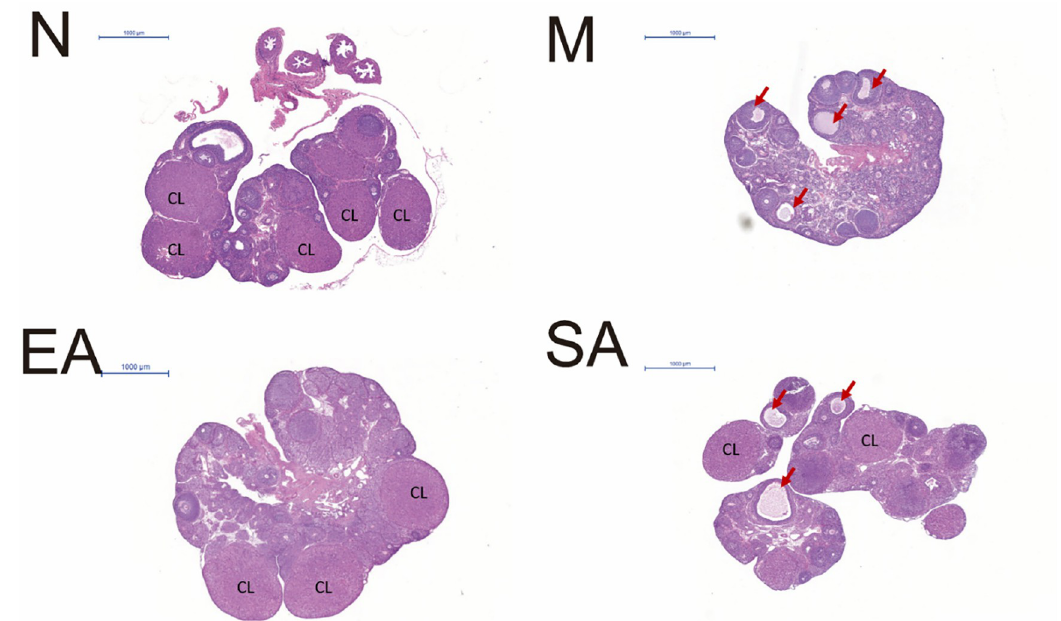
Fig 2. Morphological changes in rat ovarian tissues in the N, M, EA, and SA groups. N, normal group; M, model group; EA, electroacupuncture group; SA, sham acupuncture group; CL: Corpus luteum; Arrow: Cystic